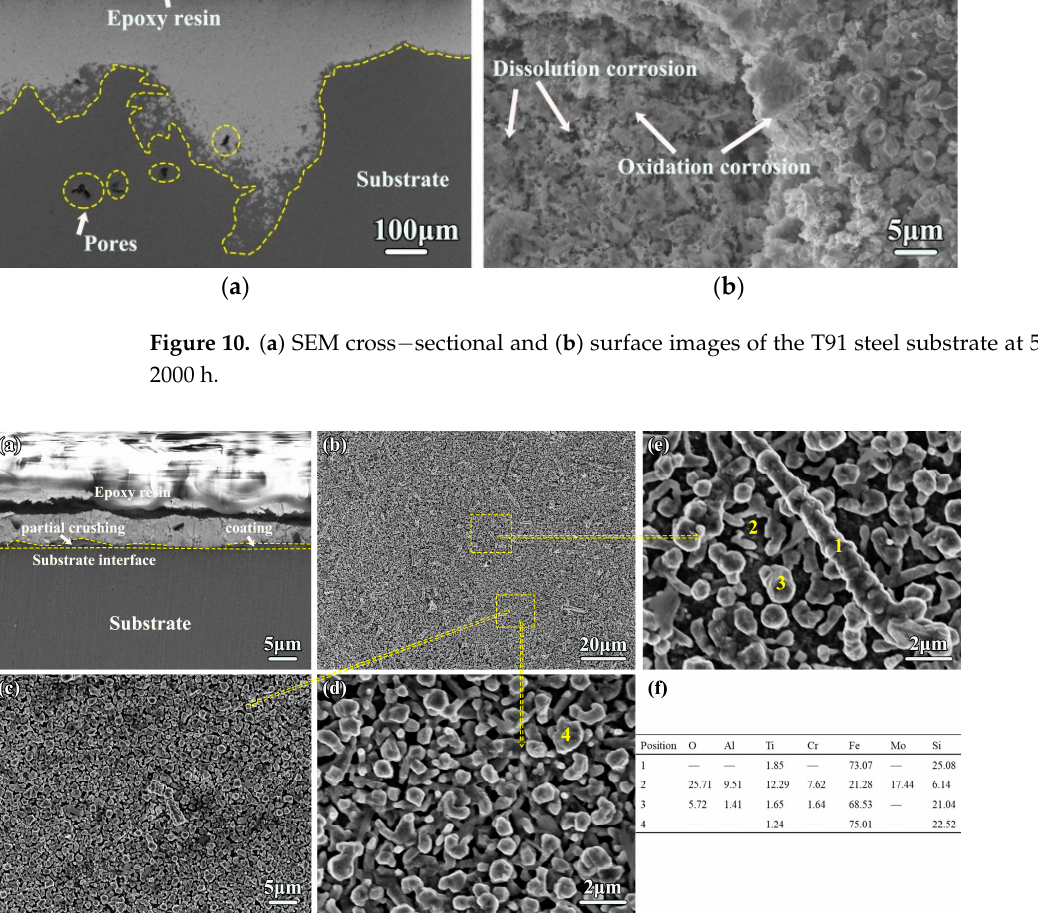
Figure 11. ( a ) SEM cross − sectional and ( b – e ) surface images of the as − deposited AlTiCrFeMoSi HEA coating at 550 °C for 2000 h; ( f ) EDS analysis of the microzone shown in ( d , e ).